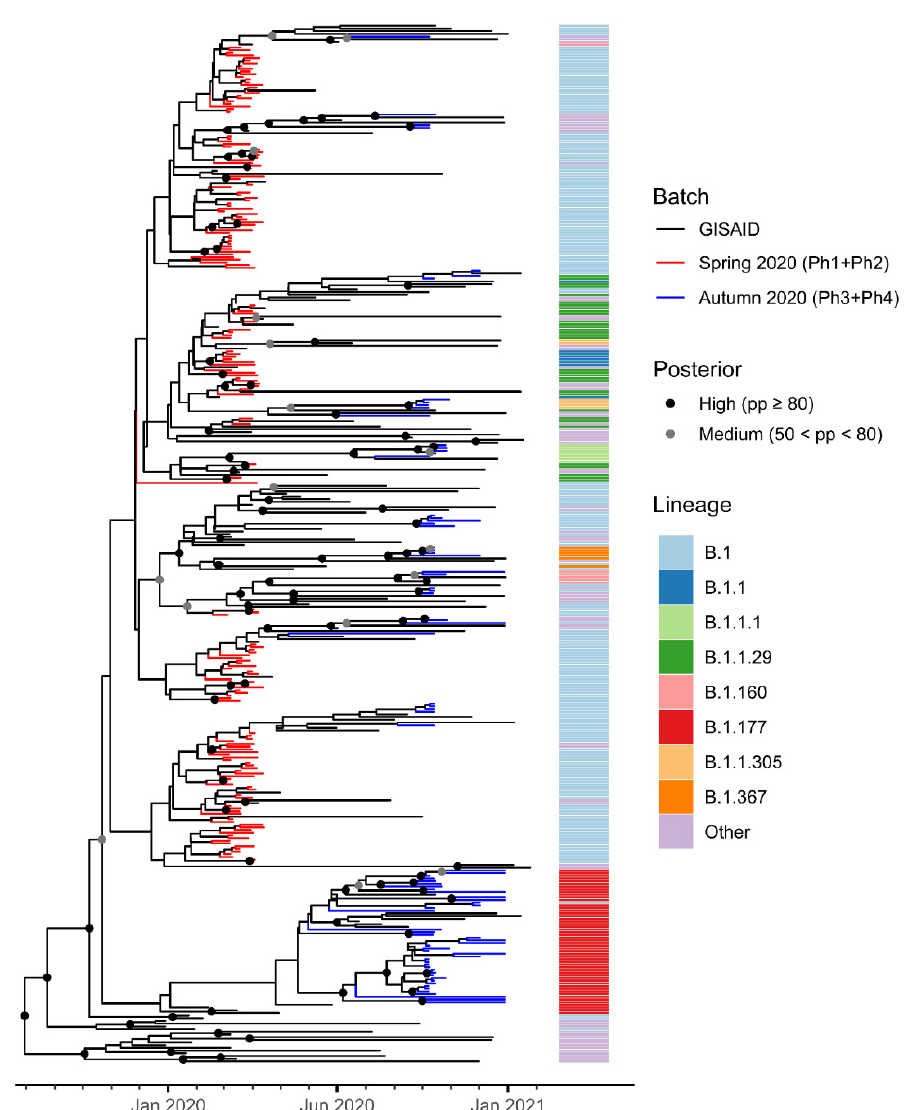
Figure 3. Phylogeny of 386 genomes of SARS-CoV-2, 253 from Trentino and 133 from GISAID. Red branches identify sequences from Trentino from samples collected in the first epidemic wave (spring 2020), while blue branches identify sequences from Trentino from the second epidemic wave (autumn 2020). Black dots mark nodes with high posterior probability (pp ≥ 80%), while gray dots mark nodes with intermediate posterior probability (50% < pp < 80%).